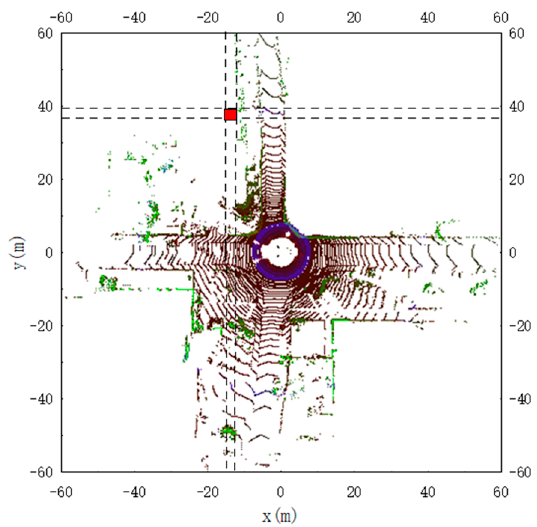
Figure 1. Schematic of CMCD blocks for multi-channel descriptors. The red area represents a pixel in the figure, and the point cloud in the corresponding three-dimensional region of the red area will be projected into this pixel